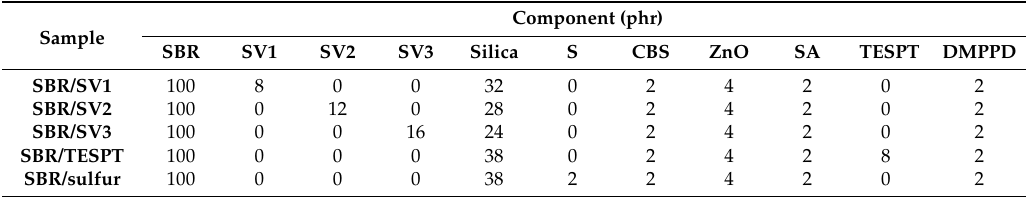
Table 1. Formulas of styrene-butadiene rubber SBR1502 (SBR)/silica nanocomposites. Note: SV1, 10 g